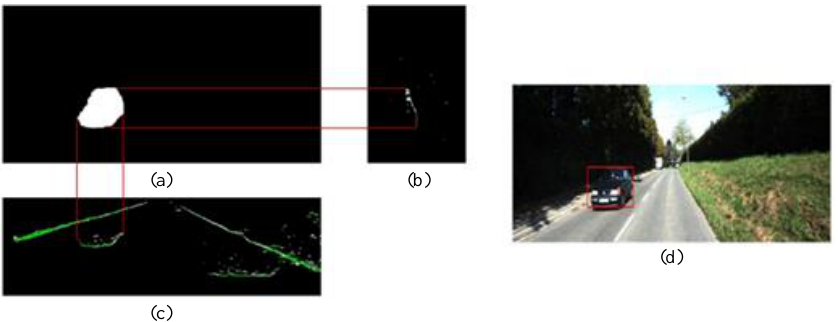
Figure 5. Obstacle detection result: ( a ) obstacle disparity; ( b ) vertical line segment fitting; ( c ) horizontal line segment fitting; and ( d ) obstacle detection.